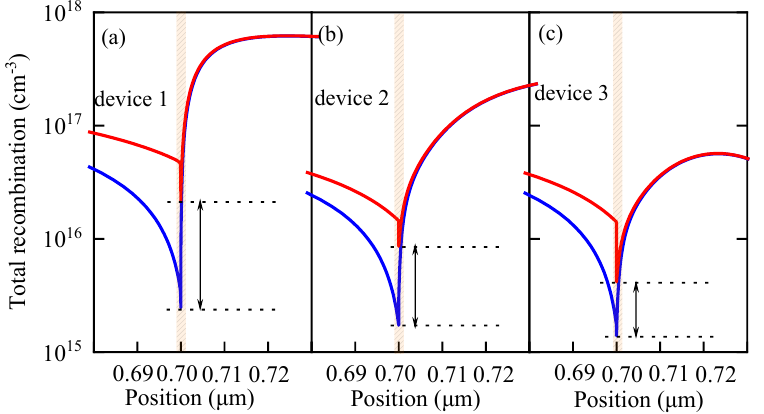
Figure 18. Effects of N it on the interface recombination: ( a ) effect of N it on the interface recombina- tion of device 1, ( b ) effect of N it on the interface recombination of device 2 and ( c ) effect of N it on the interface recombination of device 3.